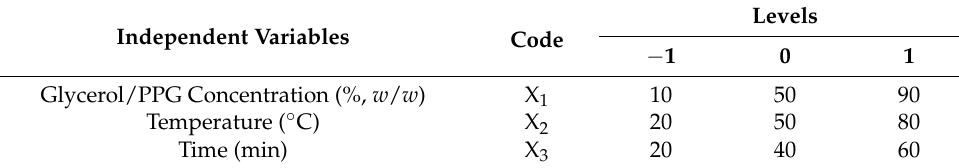
Table 1. Levels of extraction variables for the Box–Behnken designs. Independent